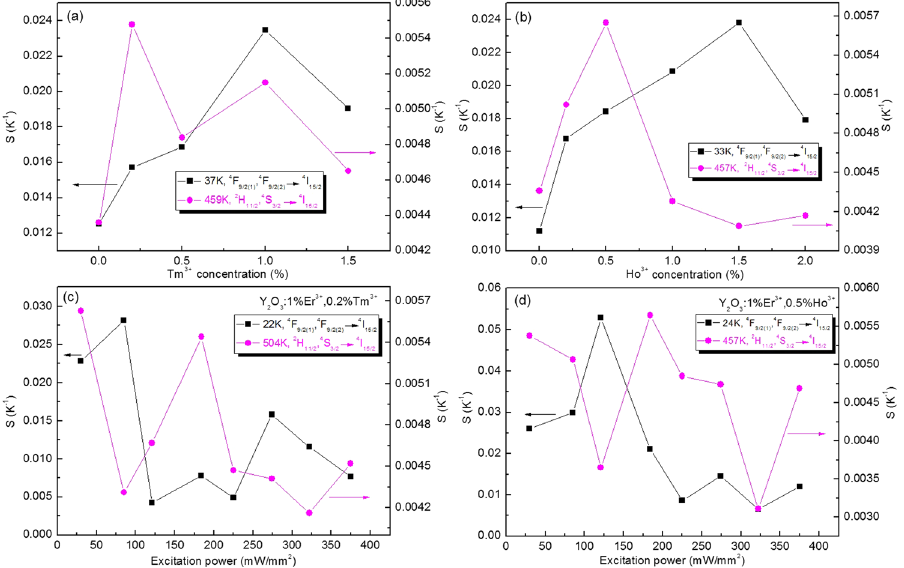
Figure 16. Doping concentration and excitation powers dependent sensitivity of Y 2 O 3 :1%Er 3 + 0.2%Tm 3 + and Y 2 O 3 :1%Er 3 + , 0.5%Ho 3 +